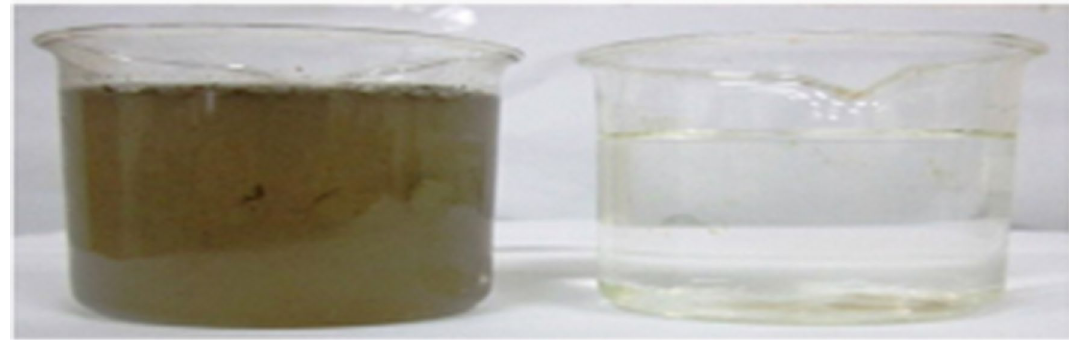
Fig. 16 Color reduction using sand/ceramics cylinders (1:0.27)